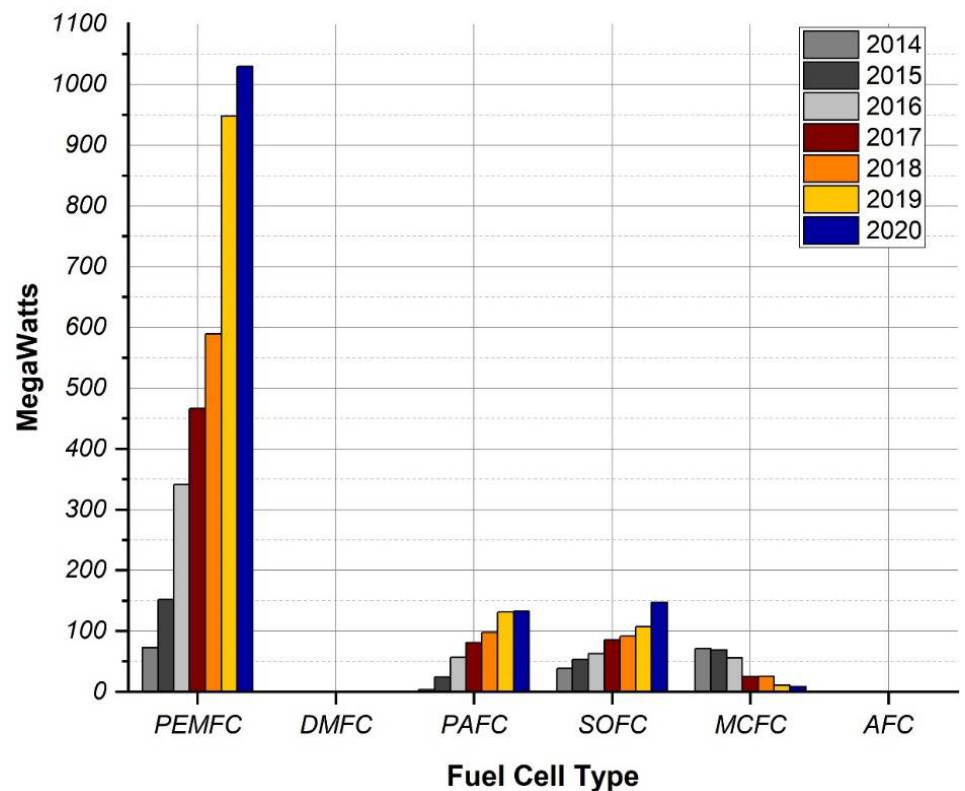
Figure 4. Fuel cell size installations.